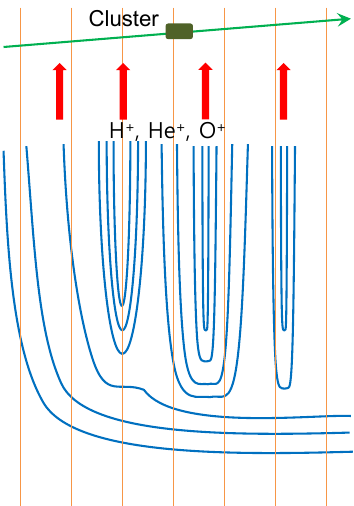
Figure 4. An illustration of the potential structure showing equipo- tential contours (blue lines) in the auroral acceleration region. Mag- netic field lines (orange lines) and outflowing ions (red arrows) are also shown. Cluster was passing through such a structure at a height of ∼ 3.5 R E